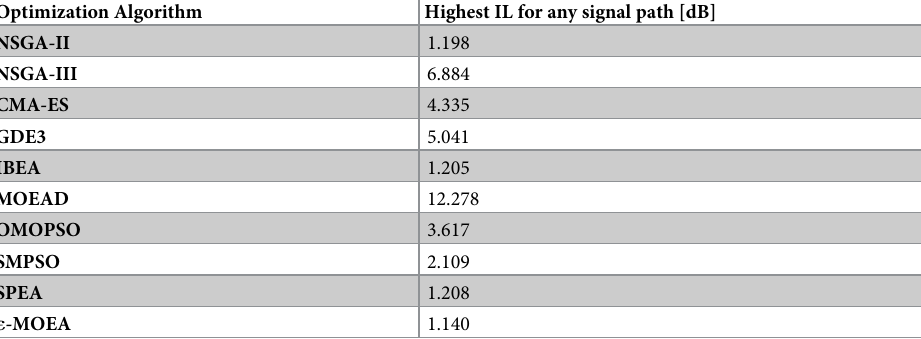
Table 1. Highest insertion loss (IL) obtained for any switch configuration for a 64x32 sized, proton only matrix when neglecting transmission line losses. Optimization Algorithm